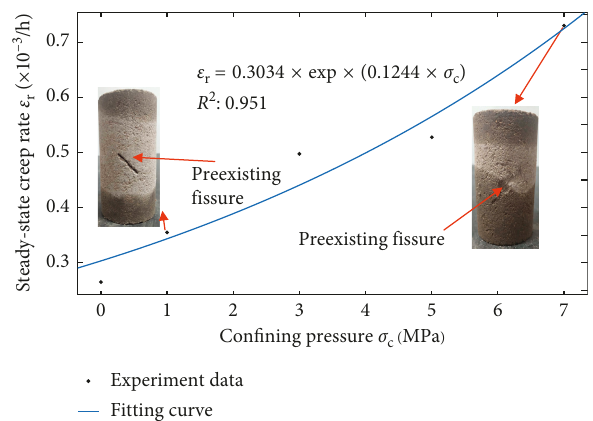
Figure 12: Steady-state creep rate at different confining pressures (T � 60 ° C).